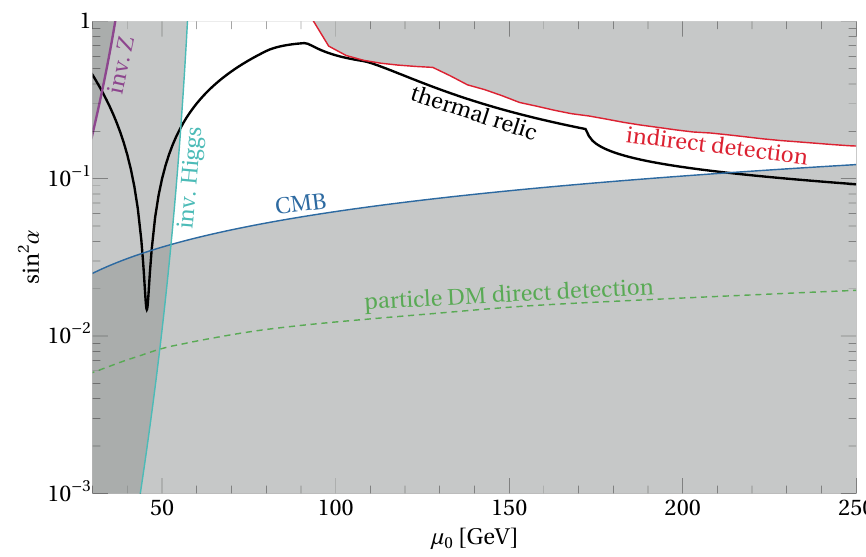
Figure 2 . Parameter space for continuum fermion Z -portal DM. The black curve reproduces the observed thermal relic density [37]. We show experimental constraints from CMB observations (blue) [38, 39], indirect detection with the Fermi-LAT experiment (red) [40–42], the LEP bound on the invisible Z width (purple) [43], and the LHC limit on the invisible Higgs branching ratio (turquoise) [44, 45]. We also show the LUX-ZEPLIN direct detection bound for ordinary particle Majorana Z -portal DM (green, dashed)